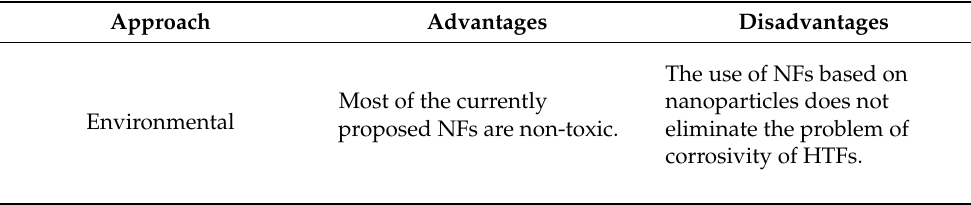
Table 5. Summary of advantages and disadvantages of nanofluids in terms of environmental, technical and economic